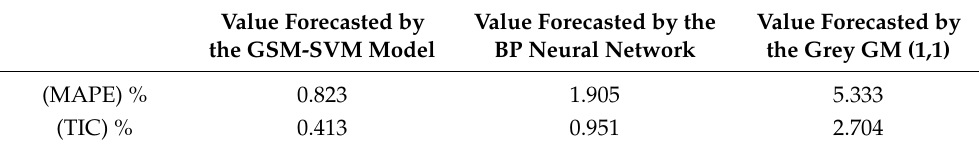
Table 5. Comparison of the forecast accuracy of the three models. Value Forecasted by Value Forecasted by the Value Forecasted by the GSM-SVM Model BP Neural Network the Grey GM (1,1) (MAPE) % 0.823 1.905 5.333 (TIC) % 0.413